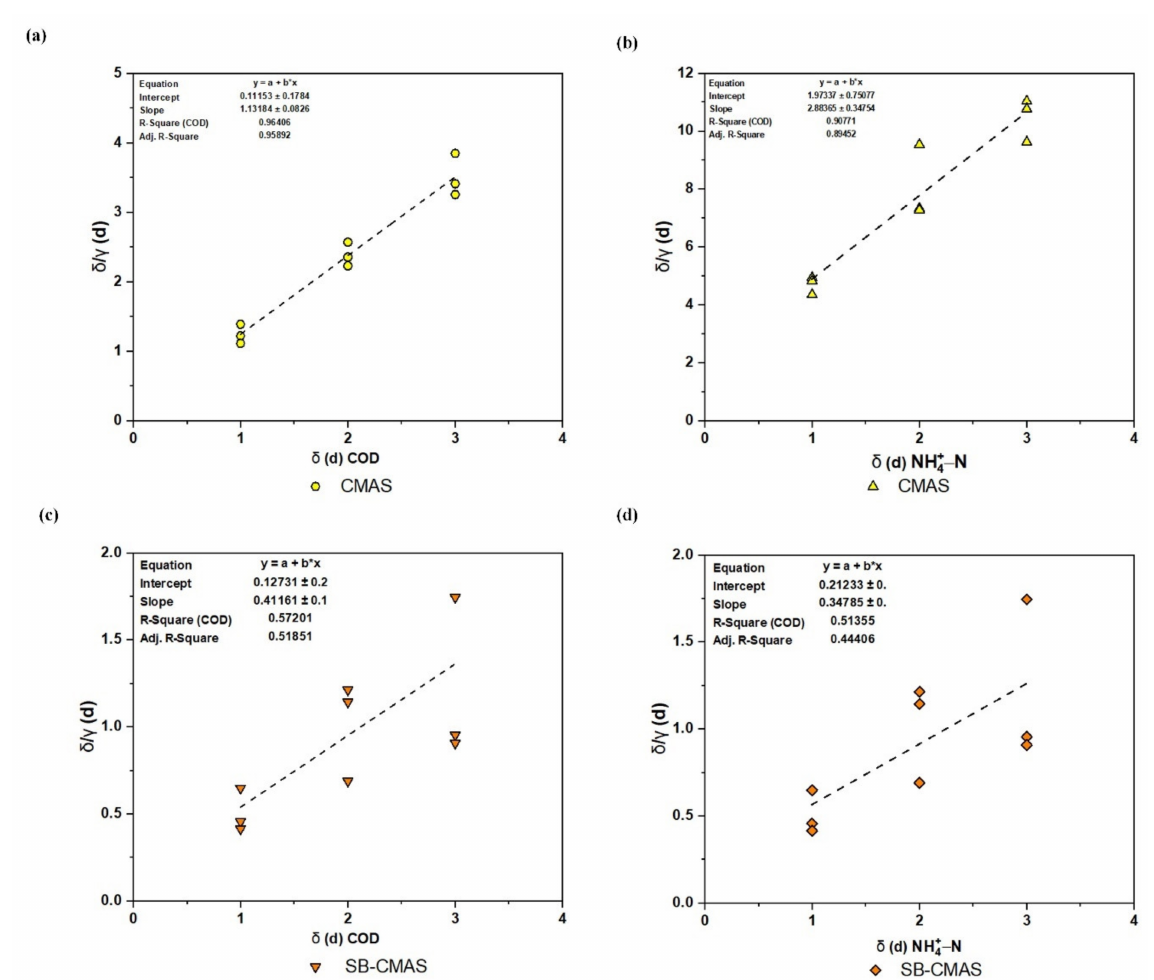
Figure 12. Second-order kinetic plot: ( a ) COD for CMAS, ( b ) NH 4+ − N for CMAS, ( c ) COD for SB-CMAS, and ( d ) NH 4+ − N for